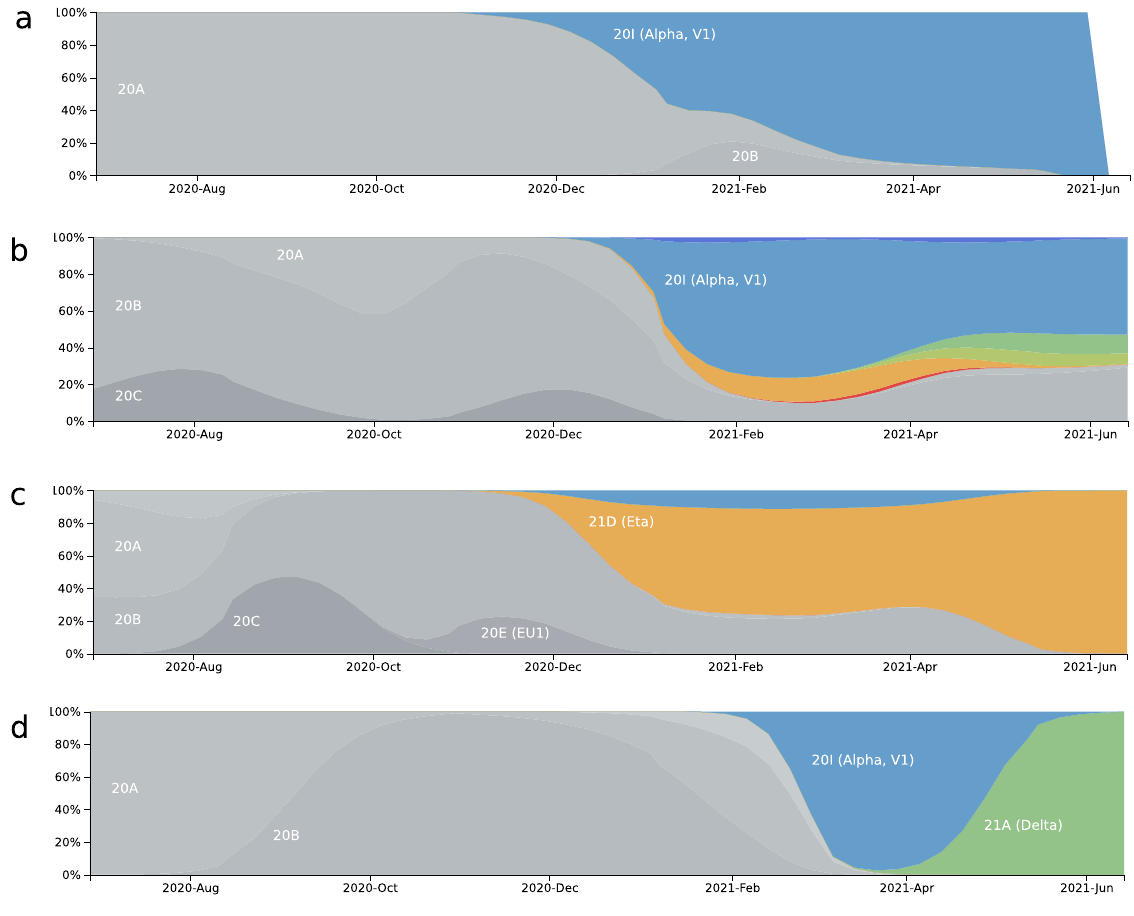
Figure 6. Distribution plot of SARS-CoV-2 variants from July 2020 to June 2021 shows distinct patterns in West African countries. This plot was generated in June 2021 and confirms our previous analysis of samples from February 2020 to April 2020 predicting a rapid spread of the variants carrying the D614G amino acid substitution. All predominating variants in June 2021 also carried the D614G, besides their characteristic amino acid changes. ( a ) Gambia is dominated by the Alpha variant. ( b ) Ghana has a combination of the variants Alpha, Delta, Kappa, Eta and Iota, dominated by the Alpha. ( c ) Nigeria is dominated by the Eta variant (B.1.525) which putatively originated from Nigeria. ( d ) In Senegal the Delta variant displaced the Alpha variant. Variants are marked by the colors blue (Alpha), green (Delta), yellow green (Kappa), orange (Eta) and red (Iota). Figure adapted from the website www. nexts train. org (accessed June 22, 2021, CC-BY 28,31 the pandemic and had incidence values ranging at about the average of European countries. Senegal and Gambia display a high positive rate going up to 50%, while Nigeria and Ghana have peaks at about 30% comparable to Switzerland. However, Nigeria has the lowest and Ghana the highest numbers of tests performed of the four countries. Switzerland started testing much later than the four West African countries but then tested at a higher rate. For the analysis of samples from February 2020 to April 2020 there were three sequence samples from Gam- bia, 15 from Ghana, 19 from Nigeria and 23 from Senegal available from West Africa. The variant distribution plots from June 2021 were based on 30 sequence samples from Gambia, 130 from Ghana, 127 from Nigeria and 41 from Senegal. The high positive rates of tests and in addition the low numbers of samples sequenced suggest a high number of undetected infections and are in line with latent circulation of new variants. Although the diversity of variants found demonstrates a certain degree of representativeness we have to state that one limita- tion of this study may be selection bias. The distinct distribution plots of SARS-CoV-2 variants in the West African countries showed that there may be more virus transmission via air traffic predominantly from Europe than via regional traffic between the West African countries themselves. Indications for this are limited to marginal occurrence of the putatively Nigerian Eta variant 14,15 in Ghana and to common occurrences of the Alpha variant in Senegal, Gambia and Ghana. Together with the partially high test-positive rates and implicated high number of undetected cases and potentially undetected new variants these results show a dynamic pandemic progression. The D614G amino acid substitution which was the most relevant change in SARS-CoV-2 in spring 2020 became prevalent in 2021 and was boosted by continuously acquired new mutations agglomerating into new variants. Fortunately, there are vaccines which are effective against new variants, and even against the new putative Nigerian Eta variant 18,27